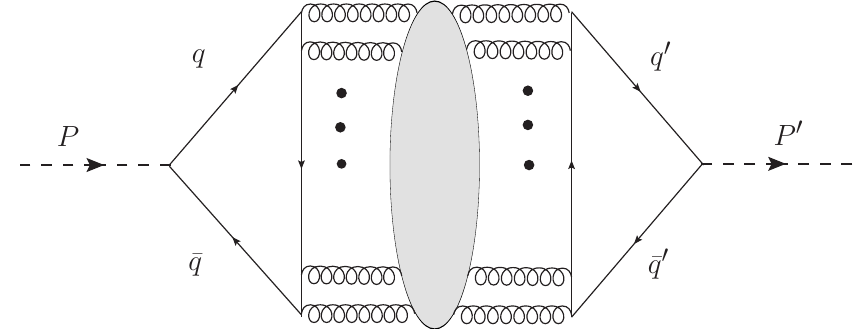
Figure 1. U A ( 1 ) anomaly-induced, hidden-flavor-mixing transitions from pseudoscalar quark–antiquark states P = q ¯ q to P ′ = q ′ ¯ q ′ include both possibilities q = q ′ and q ≠ q ′ . Springs symbolize gluons. All lines and vertices are dressed in accord with the nonperturbative QCD. Nonperturbative configurations are essential for nonvanishing anomalous mass [20] contribution to η 0 ∼ η ′ , since Q ( x ) is a total divergence. The gray blob symbolizes the infinity of all intermediate gluon states enabling such transitions, so that the three bold dots represent any even [21] number of additional gluons. Just one of infinitely many, but certainly the simplest realization thereof, is when such a transition is mediated by just two gluons (and no additional intermediate states), whereby the above figure reduces to the so-called “diamond